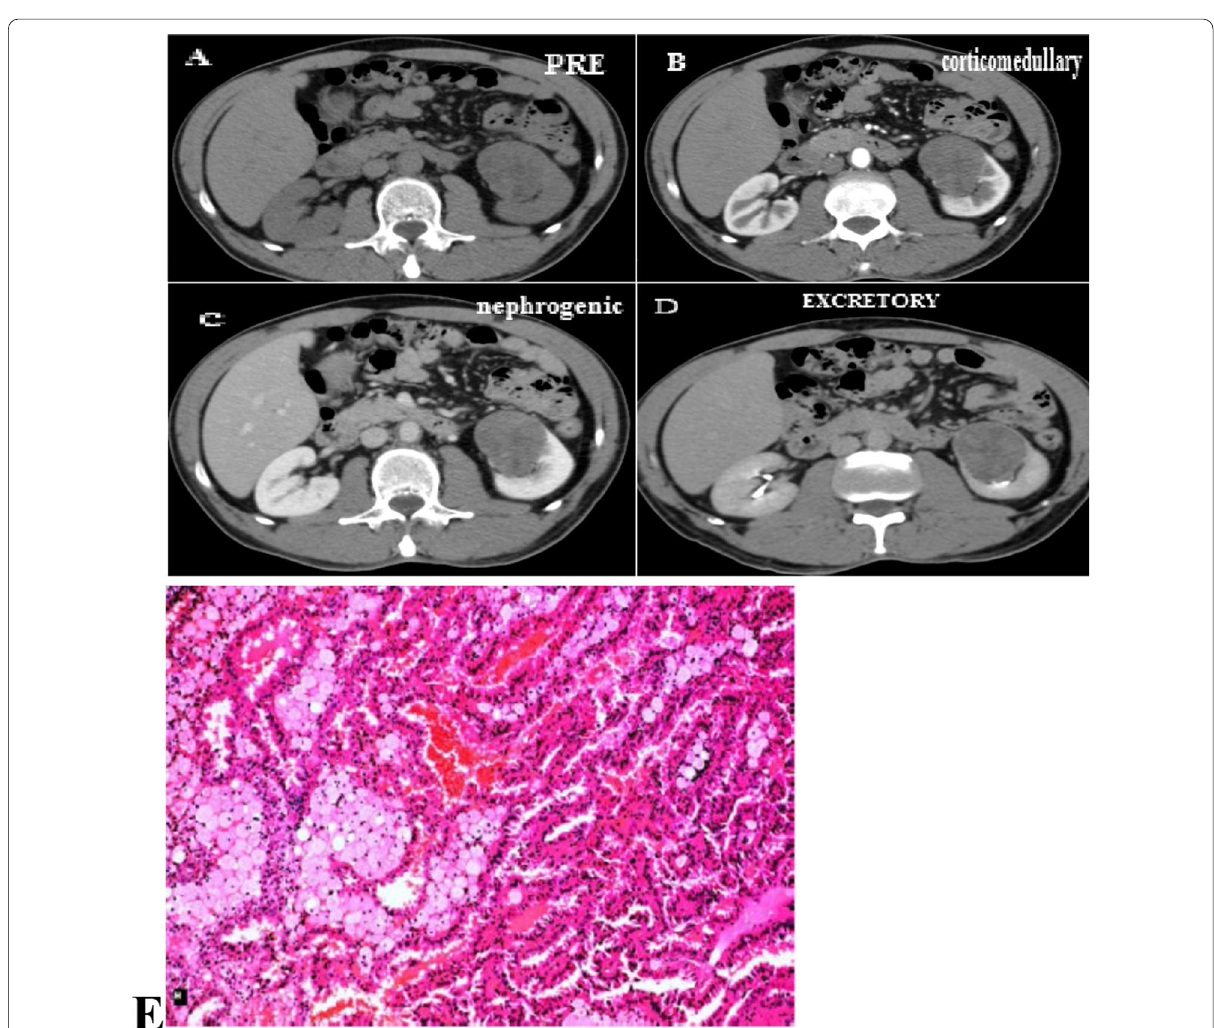
Fig. 2 Papillary cell renal cell carcinoma. A 35-year old female patient presented with left loin pain. Pre enhanced scan ( A ) shows large 12 left renal mass mid pole homogenous mildly hyperattenuating mass with mean attenuation (35 HU).Homogenous mild enhancement with mean attenuation value of the lesion is 56 HU in the corticomedullary phase ( B ). 69 HU In the nephrographic phase ( C ). 54 HU in the delayed phase ( D ). Histopathological diagnosis: papillary RCC (Image E